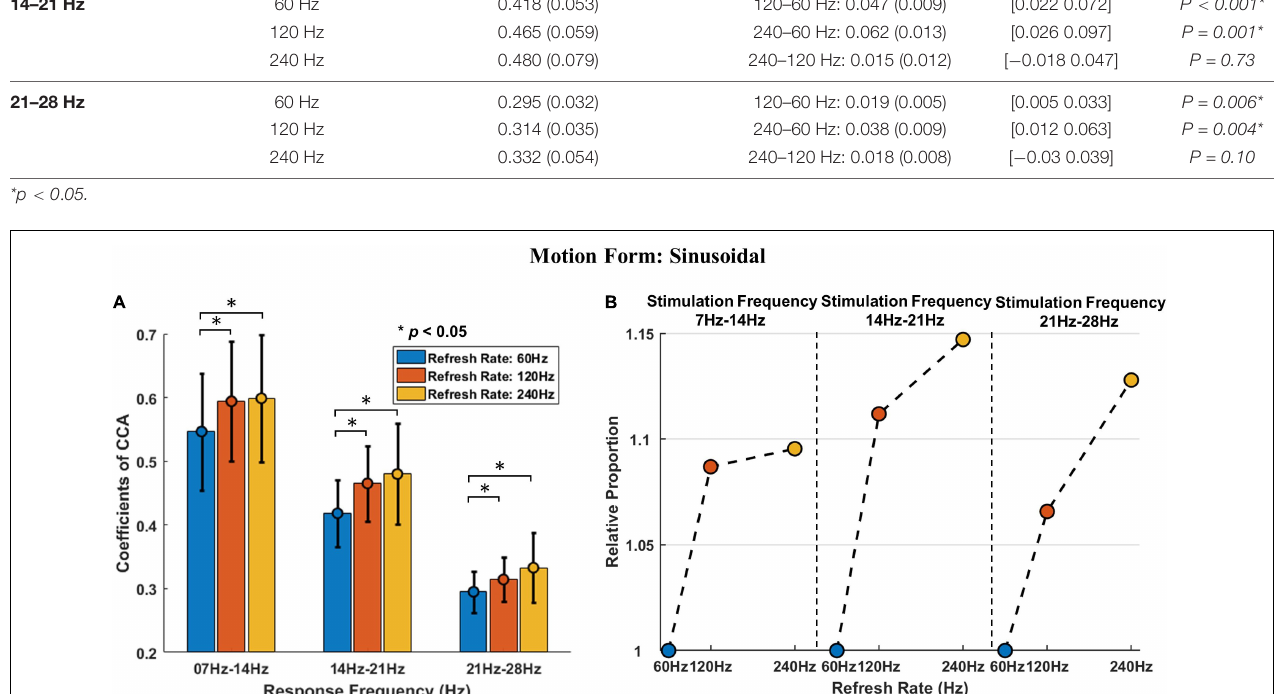
FIGURE 6 | The post hoc comparison results and relative proportion comparison of sinusoidal motion stimulation. (A) The histogram of sinusoidal motion stimulation-evoked responses, including the mean and standard deviation. The asterisks indicate that the difference is statistically significant at the level of α = 0.05. (B) The relative proportion of sinusoidal stimulation-evoked responses under different refresh rates in each stimulation frequency range. The vertical axis indicates the relative proportion, the horizontal axis indicates the refresh rate, and the black dotted thin line is used to separate different stimulation